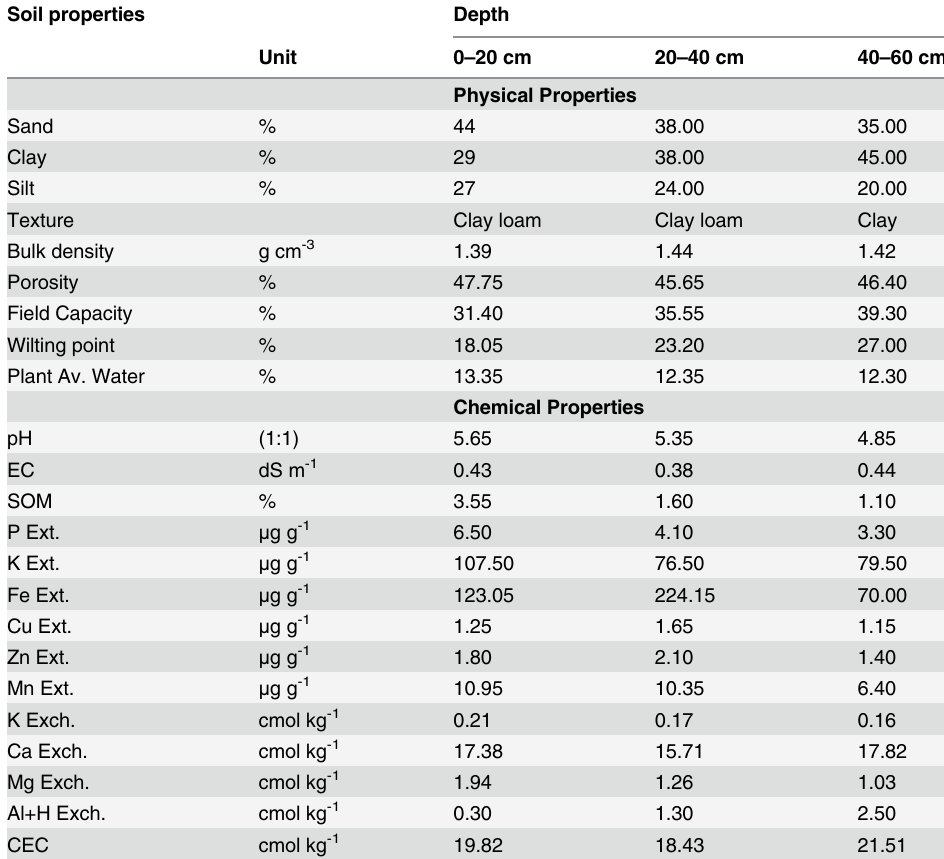
Table 1. Physical and Chemical Properties of Soil Under SF, Before the Initiation (2004) of Cacao Agroforestry Management Systems (INAS,